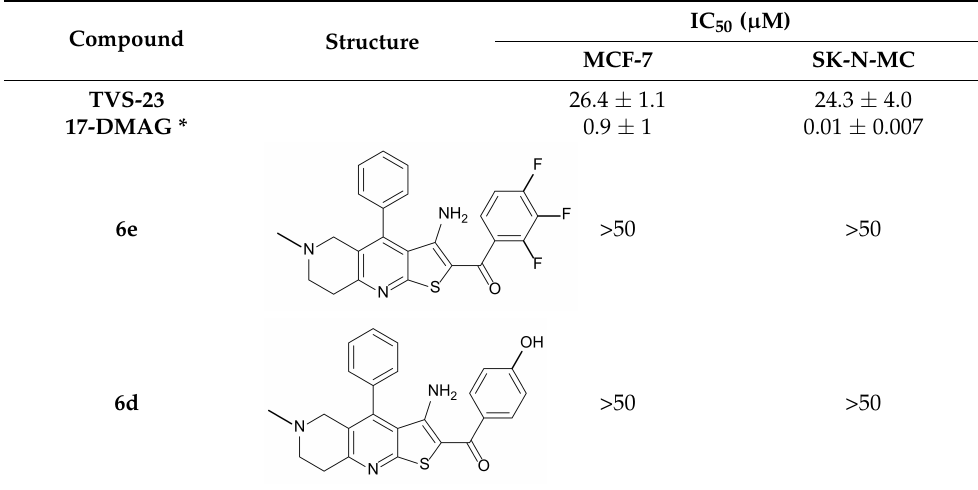
Table 1. IC 50 values for the antiproliferative activity of compounds 6e and 6d in the MCF-7 and SK-N-MC cell lines: exploration of importance of the phenyl ring